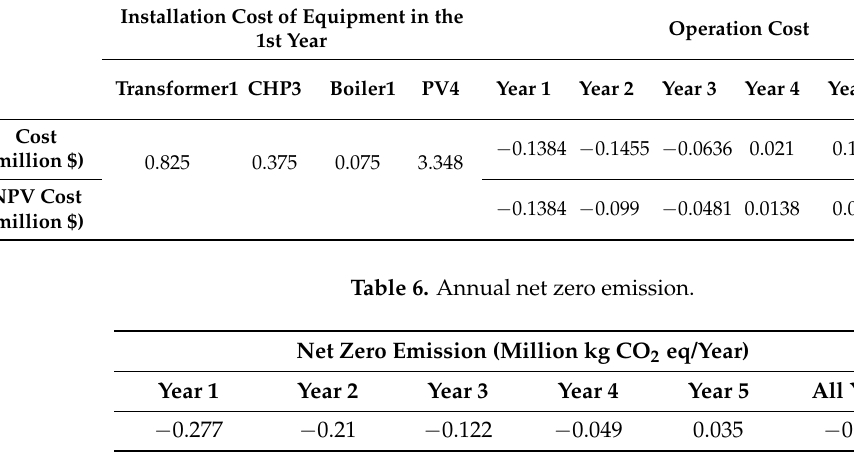
Table 7. Comparison of the total NPV cost and NZE for different